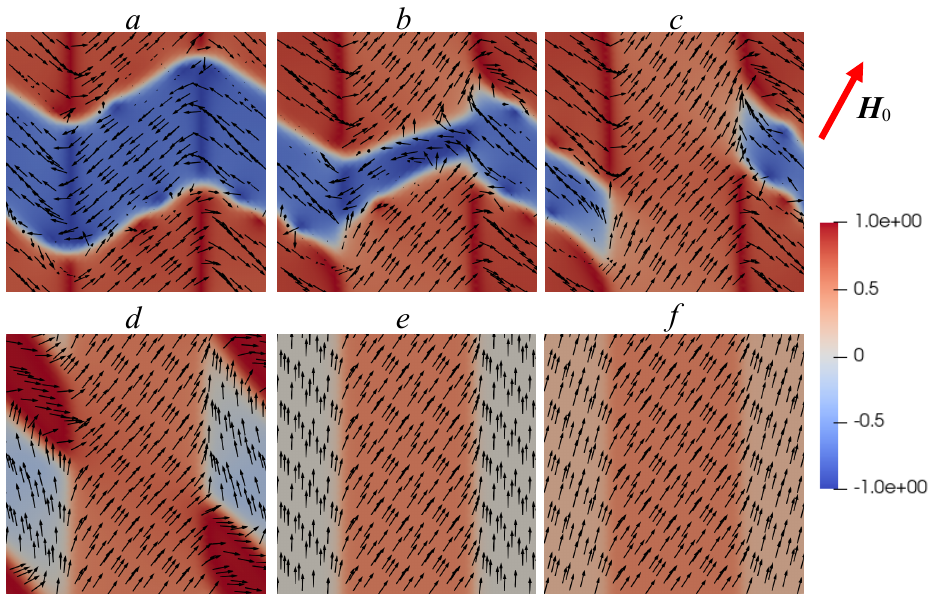
Figure 5. Evolution of the magnetization vector when an external magnetic field is applied at an angle of 28.65 ◦ to the y axis: ( a )— ˜ H 0 = 0, ( b )— ˜ H 0 = 0.19, ( c )— ˜ H 0 = 0.2, ( d )— ˜ H 0 = 0.65, ( e )— ˜ H 0 = 0.75, ( f )— ˜ H 0 = 1.5.